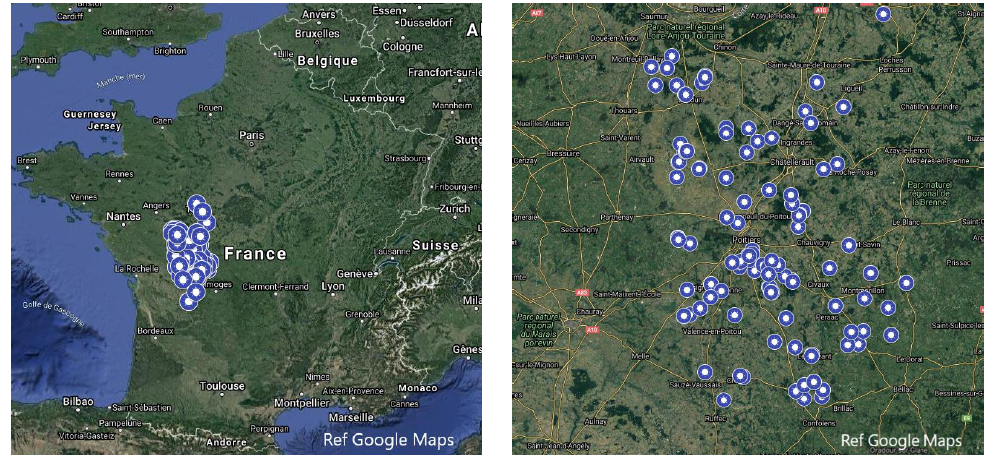
Figure 1. The 136 PV power plants in the test case d . The figure on the right is a zoom of the one on the